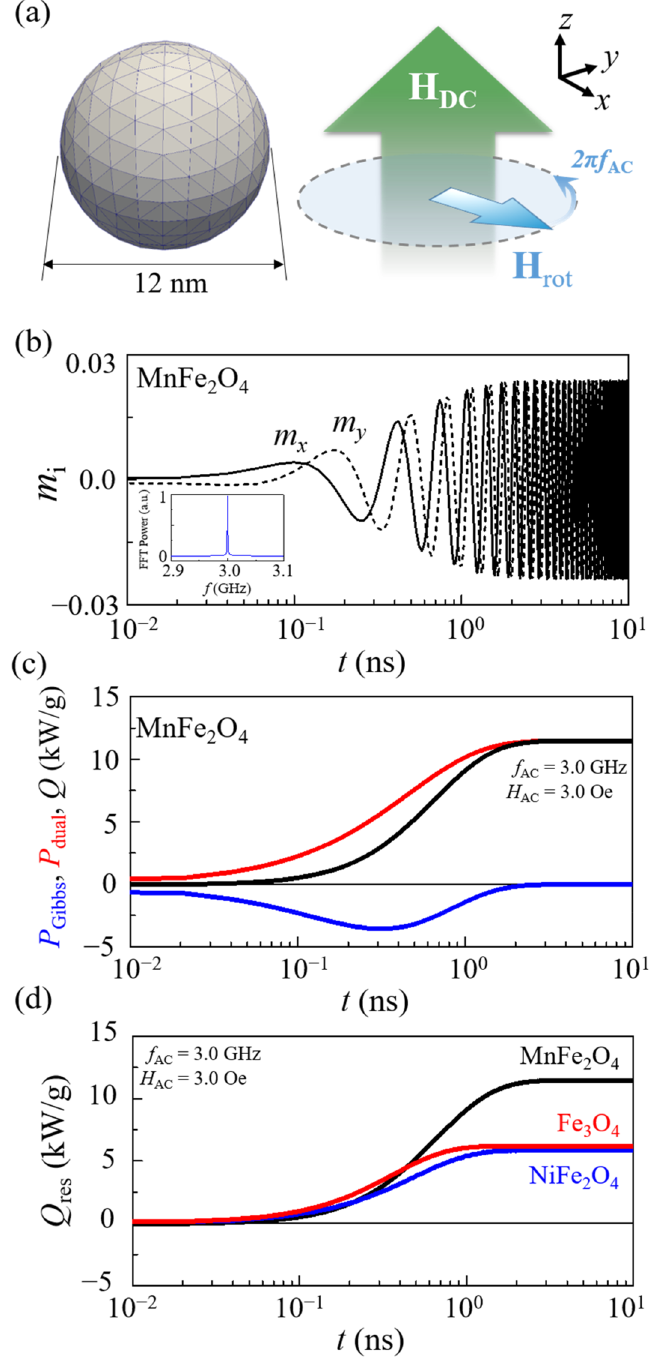
Figure 2. ( a ) Single-domain nanosphere of diameter 2 R = 12 nm and MnFe 2 O 4 under application of H DC = 1010 Oe in + z direction. ( b ) Upon application of CCW rotating field ( f AC = 3.0 GHz, H AC = 3.0 Oe) on xy plane, x and y components of magnetization start to oscillate with increasing amplitude with time, and then reach steady state of precession at specific polar angle of ~ 2º. The inset shows the FFT power, which indicates that the oscillation frequency is the same as f AC = 3.0 GHz. ( c ) Temporal variation of P Gibbs (blue line) and P dual (red line), Q (black line) = P Gibbs + P dual , calculated using simulation data under resonance field condition ( f AC = 3.0 GHz and ¯ Q H DC = 1010 Oe) with H AC = 3 Oe. (d) res variation for MnFe 2 O 4 (black line), Fe 3 O 4 (red line), and NiFe 2 O 4 (blue line) for same frequency of f AC = 3.0 GHz with H AC = 3 Oe, but with different DC field strengths H DC = 970, 1010, and 980 Oe, respectively, to meet corresponding resonance